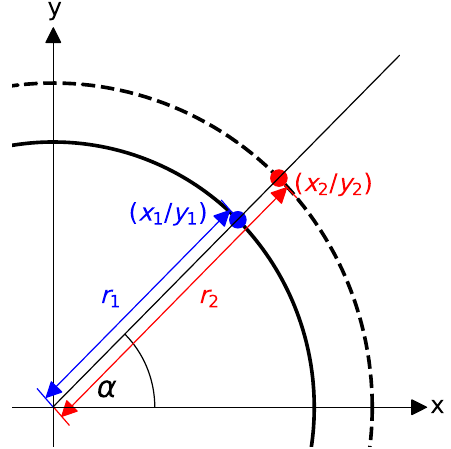
FIG. 4. Schematic plot of radial difference between two concentric circular accelerators, approximated by circles, at a given angle α